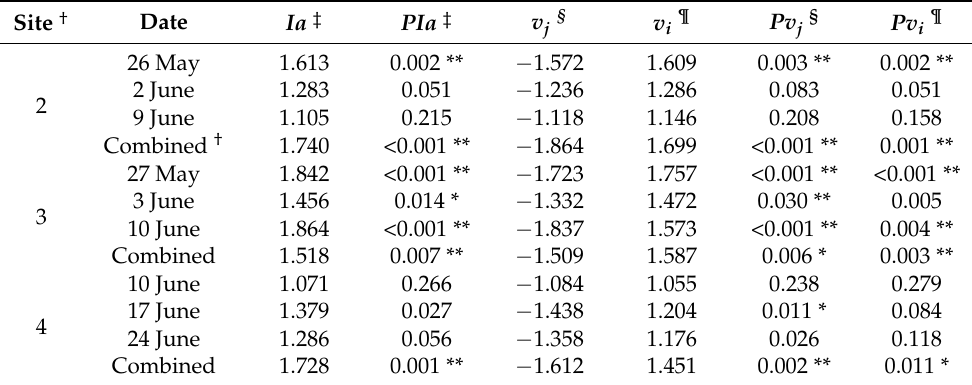
Table 4. Parameters for the spatial distribution patterns of Sphenophorus venatus vestitus adults using SADIE at three sites in Marshallville, Georgia (USA) in